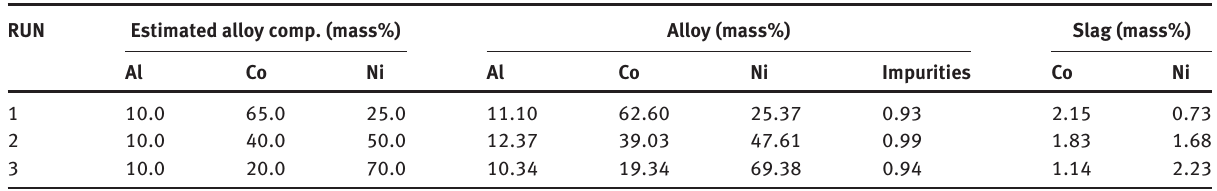
Table 4: Chemical analysis results of obtained SHS alloys under normal gravity conditions by the addition of 20 mass% Al 2 O 3 into the green mixtures RUN Estimated alloy comp. (mass%) Alloy (mass%)